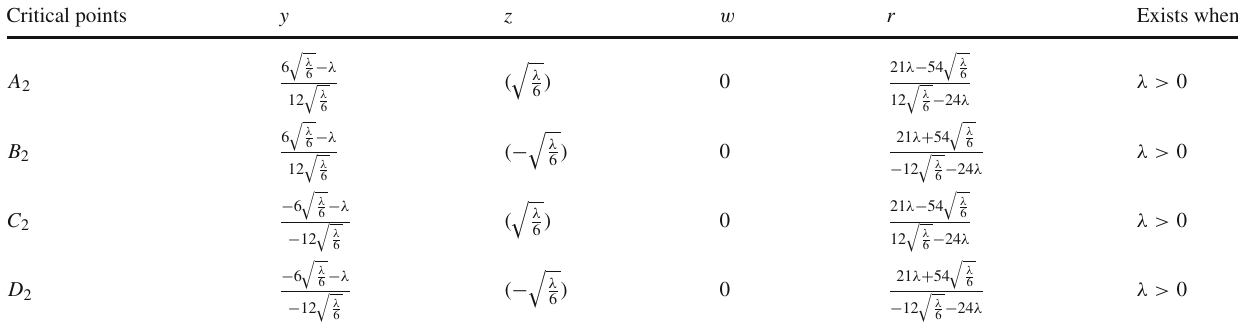
Table 7 Critical points of this system of equations Critical points